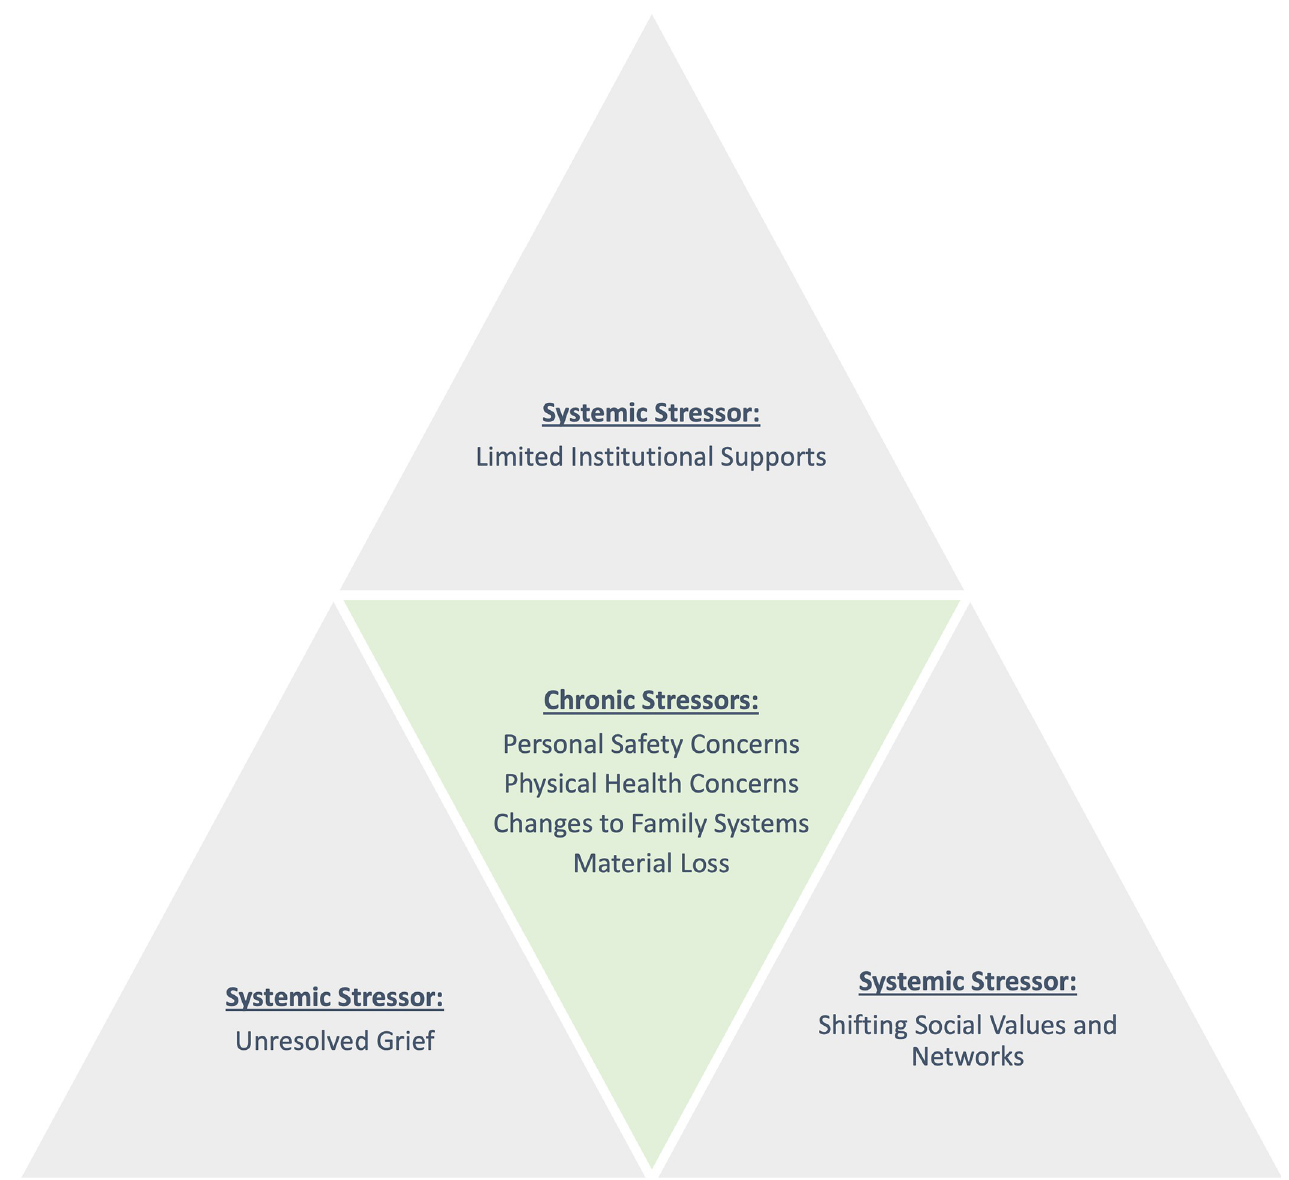
Fig 1. Social ecological model of